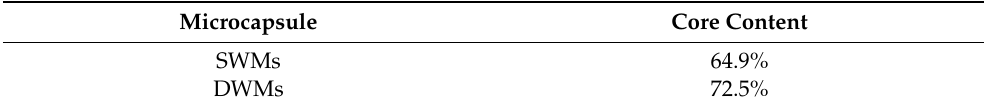
Table 3. Core fraction of SWMs and DWMs.